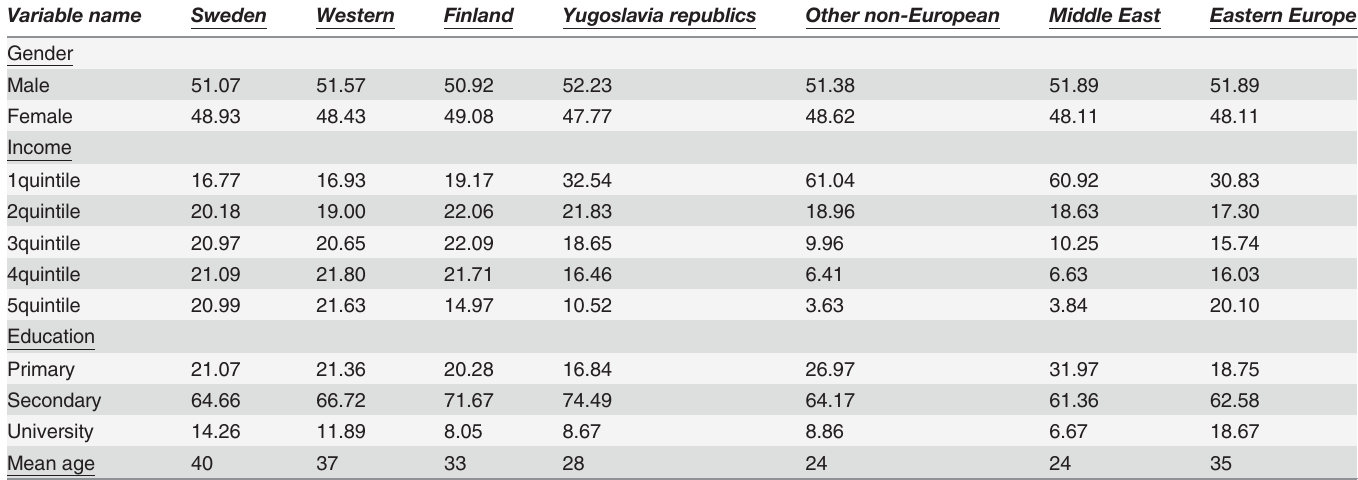
Table 2. Distribution of socioeconomic indicators across countries presented as proportions (%).